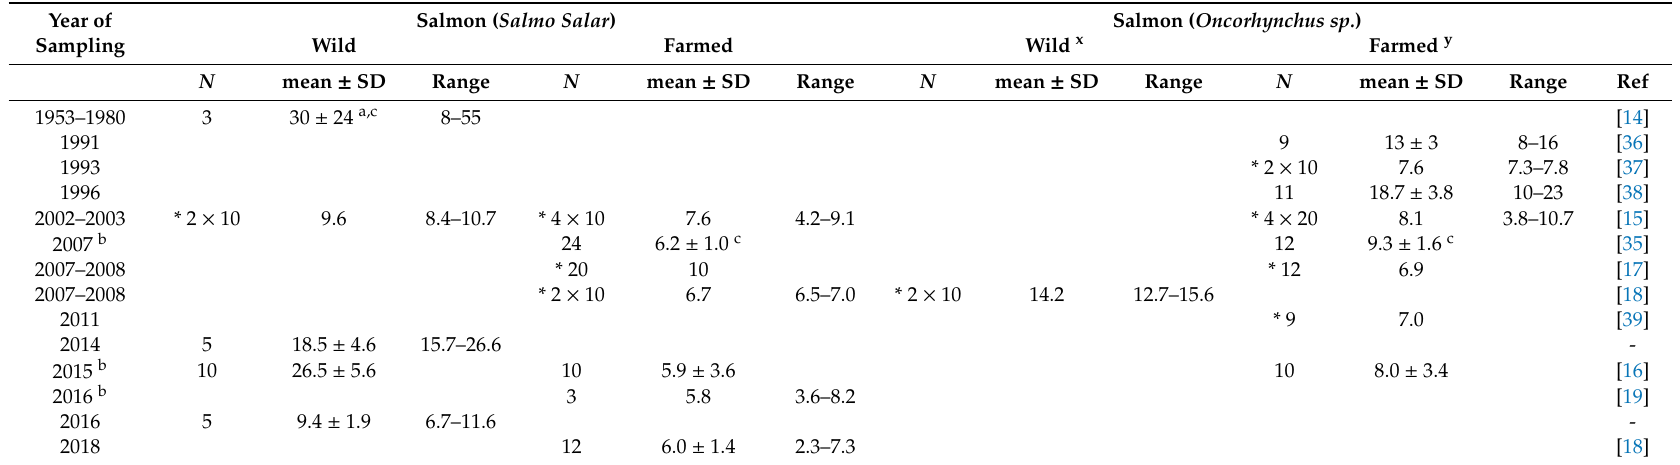
Table 1. Content of vitamin D 3 ( µ g / 100 g fillet) of Atlantic salmon ( Salmo salar ) and Pacific salmon ( Oncorhynchus sp. ) from 1953–2018, either wild or farmed. If published, sampling year, number of samples ( N , either analysed in single or as composite samples), mean ± SD and range are included. Year of Salmon ( Salmo Salar ) Salmon ( Oncorhynchus sp. )